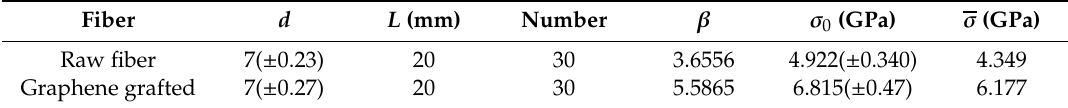
Table 1. Tensile strengths and Weibull moduli of CFs before and after grafting GO.